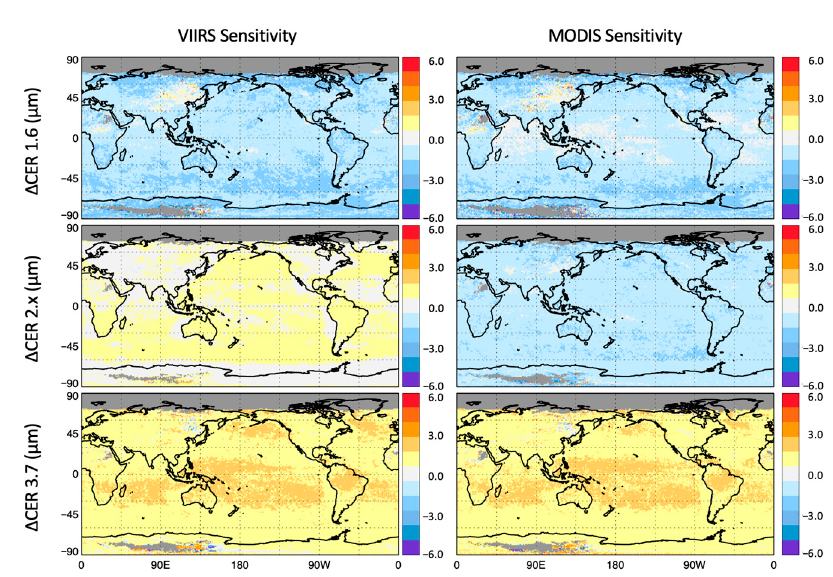
Figure 5. Di ff erences in gridded cloud e ff ective particle radius (CER) for February 2014. Left column is VIIRS v1.1 cloud continuity algorithm CERs, with lookup tables (LUTs) computed from the 265 K index of refraction datasets, minus CER from the VIIRS v1.1 algorithm using the 300 K LUTs. Right column is MODIS v1.1 CERs using the 265 K LUTS minus MODIS v1.1 using 300 K LUTS.